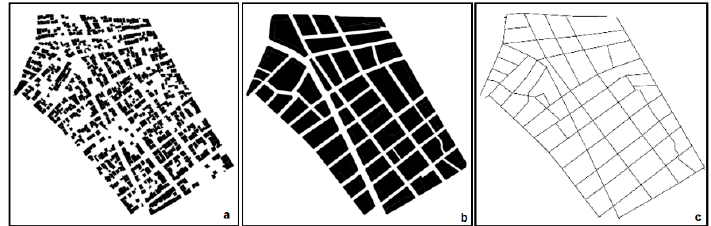
Figure 2. Eight-bit black-and-white input data of ( a ) buildings, ( b ) blocks, and ( c ) street networks prepared for calculating fractal dimension (FD) values on a neighborhood basis.